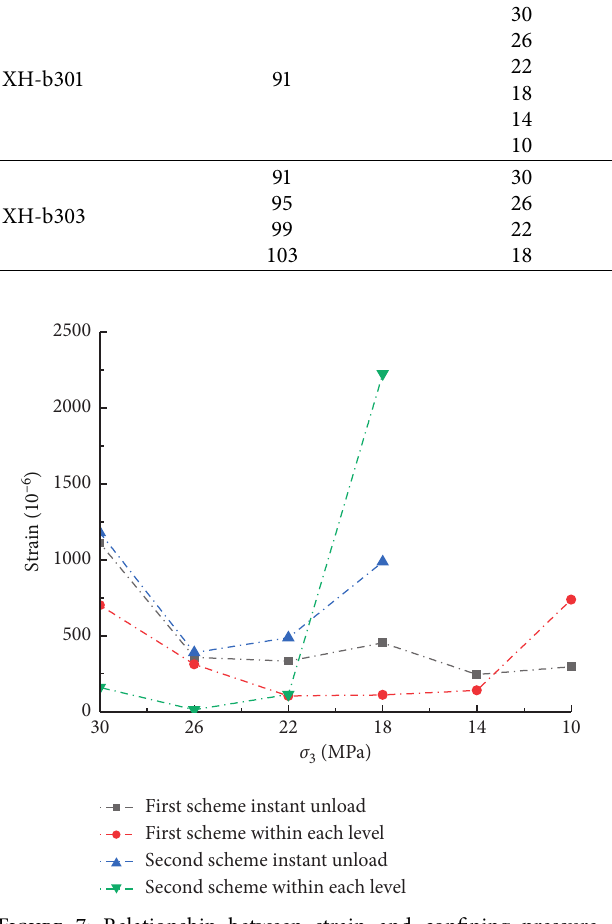
Figure 7: Relationship between strain and confining pressure under two schemes.